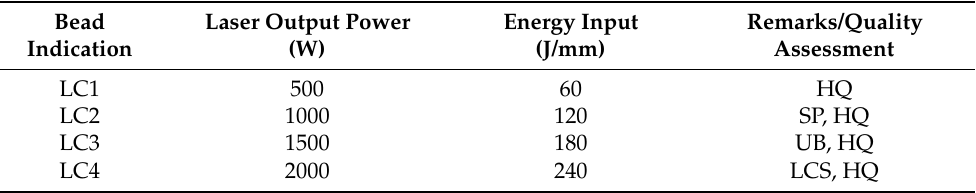
Table 2. Parameters of laser cladding of experimental composite NiCrBSi/WC + W 2 C powder, Figure